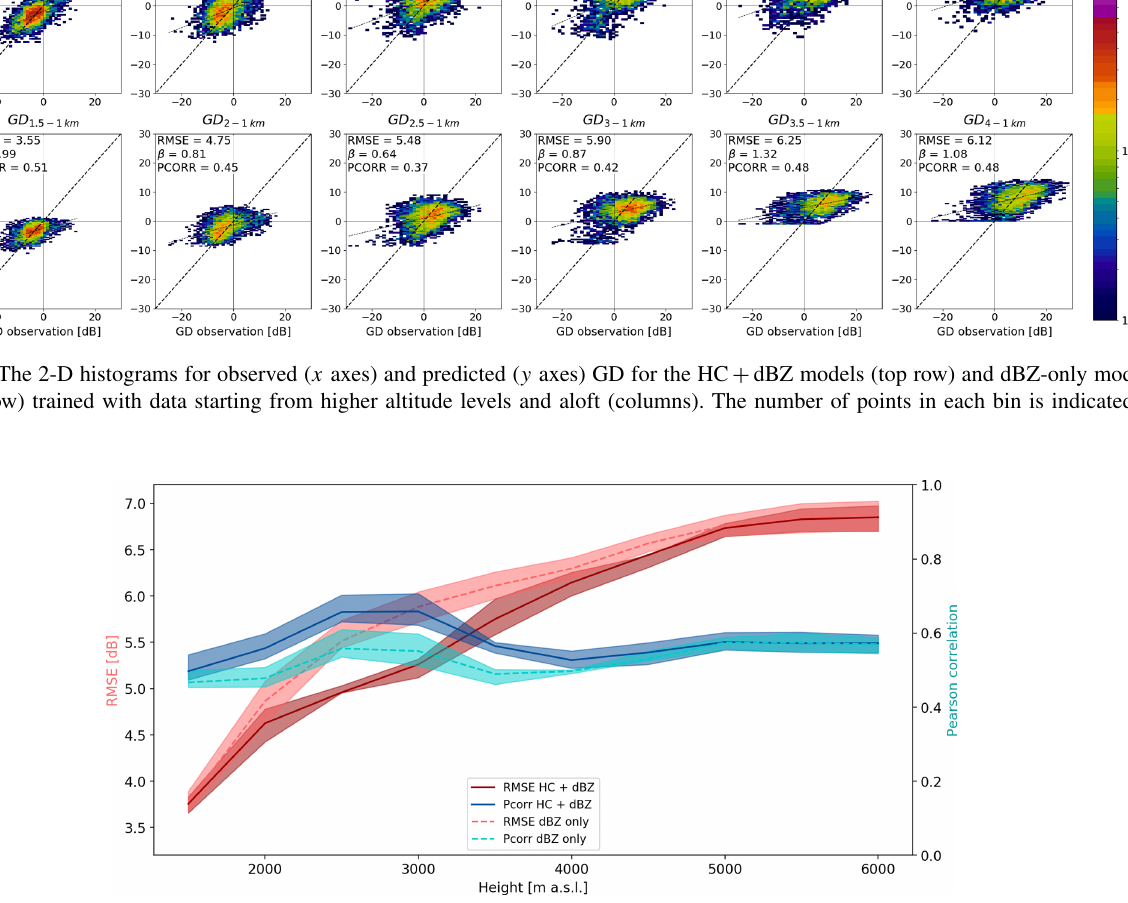
Figure 6. RMSE and Pearson correlation coefficient for dBZ-only models and HC + dBZ models trained with data starting from increasing altitude levels. The thick lines indicate the average values and the shading the quartiles calculated over 10 model runs using different combinations of events for the training, validation and testing data